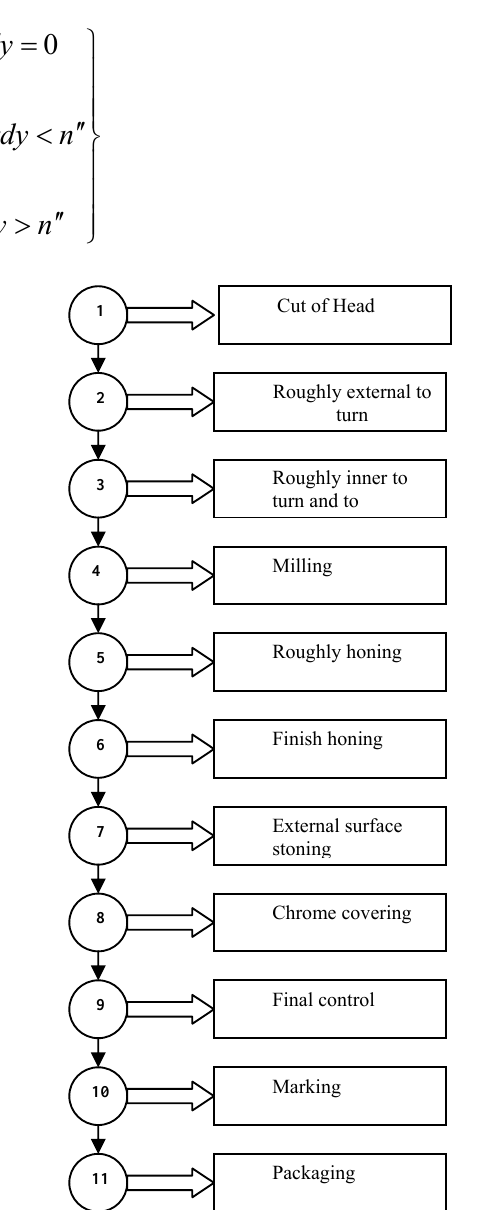
Fig. 8. Operations of engine cylinder